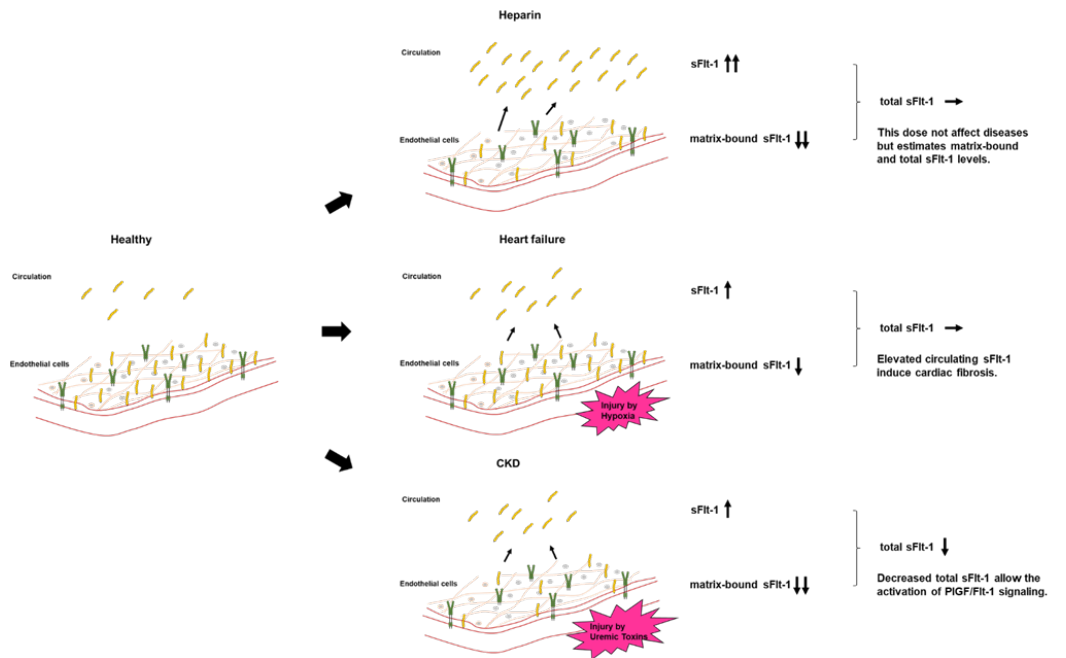
Figure 5. Pre- and post-heparin sFlt-1 levels in HF and no HF. Pre-heparin sFlt-1 levels are significantly increased in HF, but post-heparin sFlt-1 levels are similar between HF and no HF. HF is defined by brain natriuretic peptide ≥ 200 pg/mL.